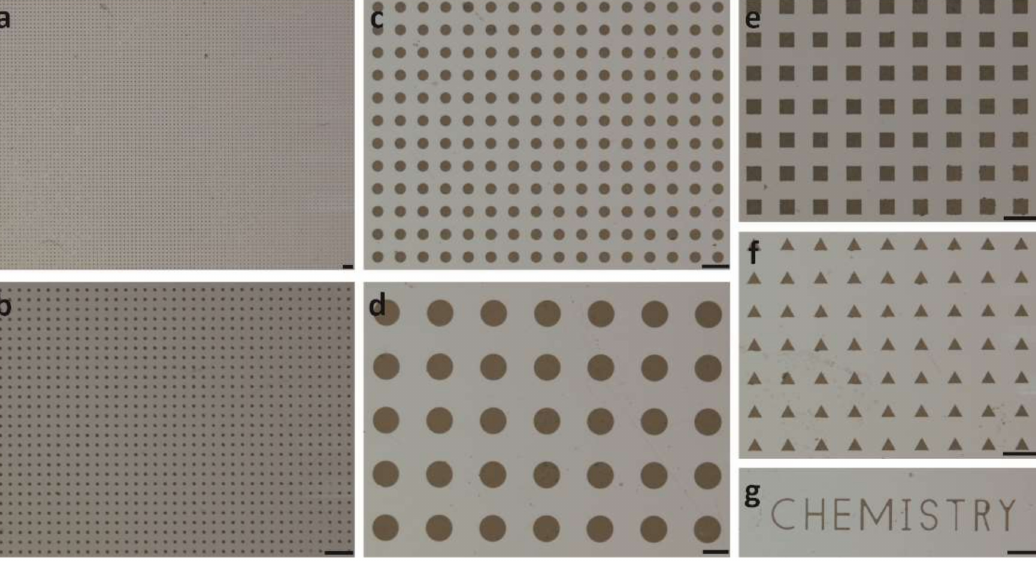
Figure 5. Optical images of the multiple graphene oxide patterns modified on Cytop surface. ( a ) A 100 × 100 array of graphene oxide circles with 50 µ m diameter. ( b ) The blow-up of part of ( a ). ( c ) An array of graphene oxide circles with 200 µ m diameter. ( d ) An array of graphene oxide circles with 500 µ m diameter. ( e ) An array of graphene oxide squares with 200 µ m side length. ( f ) An array of graphene oxide triangles with 200 µ m side length. ( g ) “CHEMISTRY” letters made of graphene oxide thin film. Scale bars: 500 µ